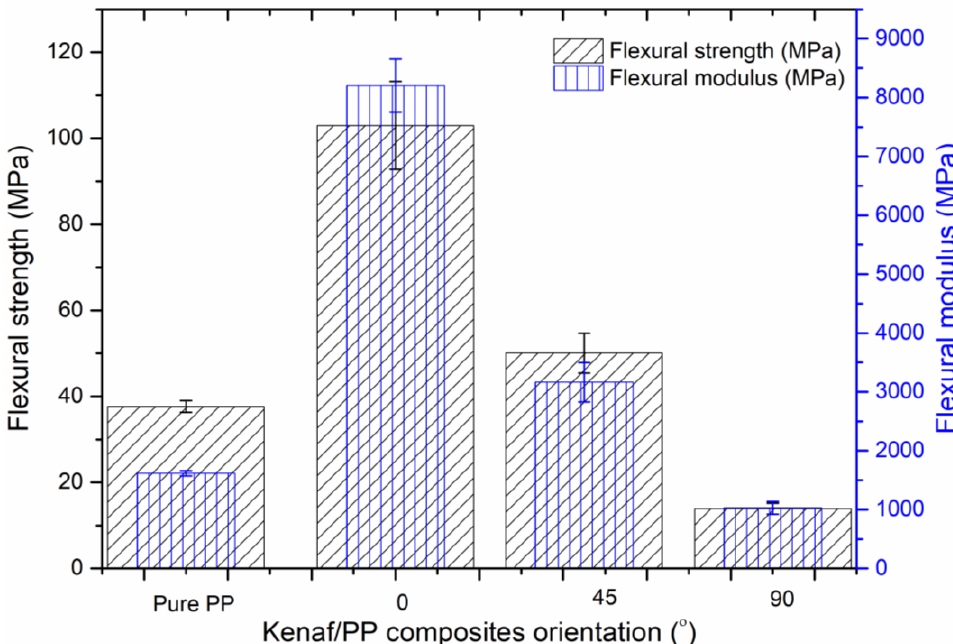
Figure 5. Flexural strength and flexural modulus of kenaf / polypropylene (PP) composites at di ff erent orientation angles at temperature of 120 ◦